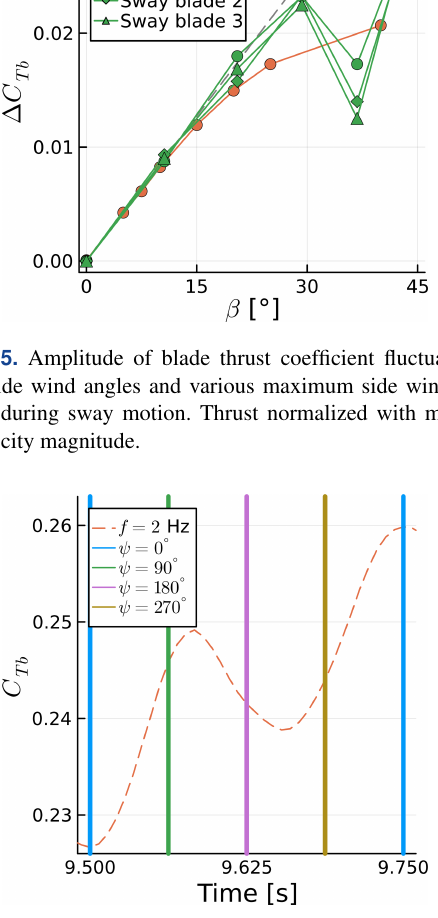
Figure 16. Time history of blade 1 thrust coefficient for a sway case. Vertical lines show blade azimuth.